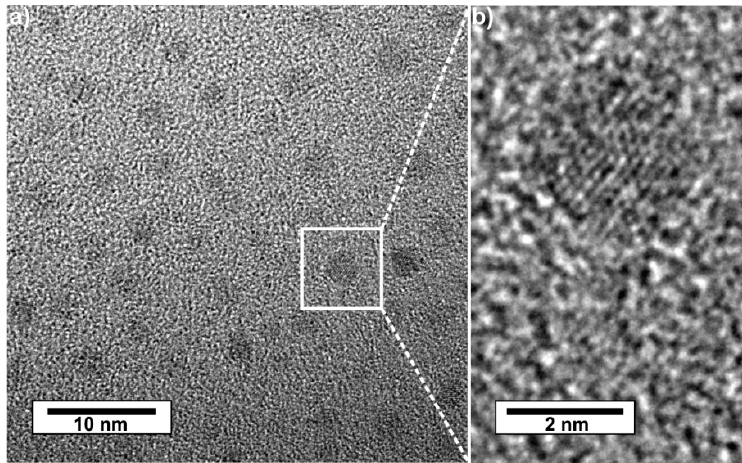
Figure 2. Size and size distribution of the as-prepared C-dots: ( a ) overview transmission electron microscopy (TEM) image; ( b ) high-resolution (HR)TEM image with lattice fringes.